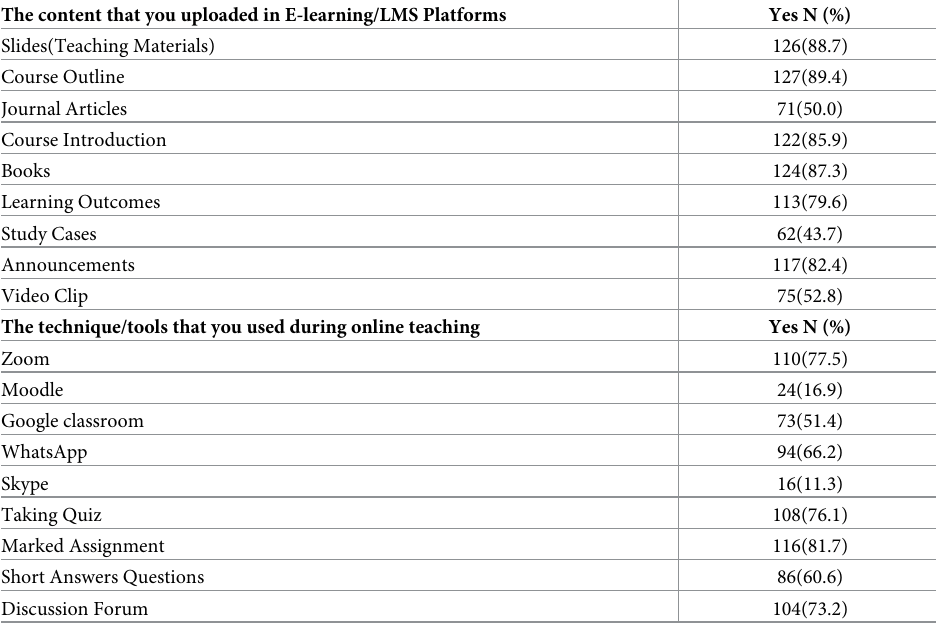
Table 2. Content type and techniques used by pharmacy faculty during online